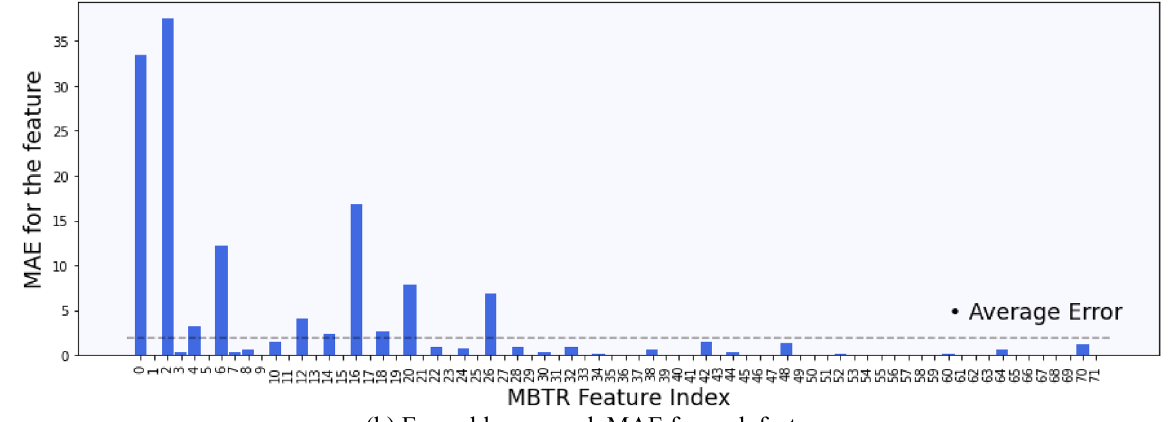
Figure 2. Time series model performance. ( a ) A scalar value predicted by each model from the ensemble approach and multivariate prediction by the transformer model for a sample data pair of the NCL11 NP design from the test set. The differences between the heights of the bars representing the predictions and the ground- truth values indicate the prediction errors. ( b ) MAE for each XGBoost model from the ensemble approach over the whole test set. The dashed line represents the average error across all